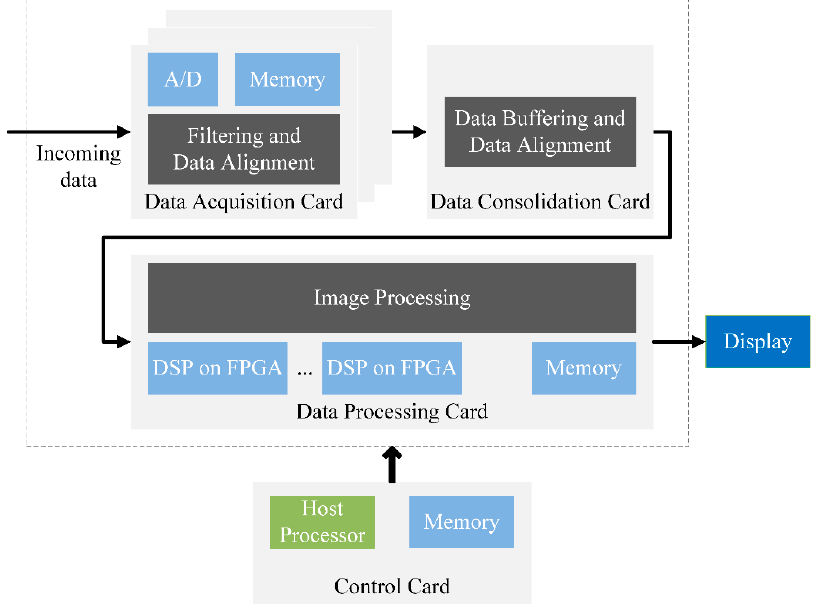
Figure 1. The typical medical imaging system.